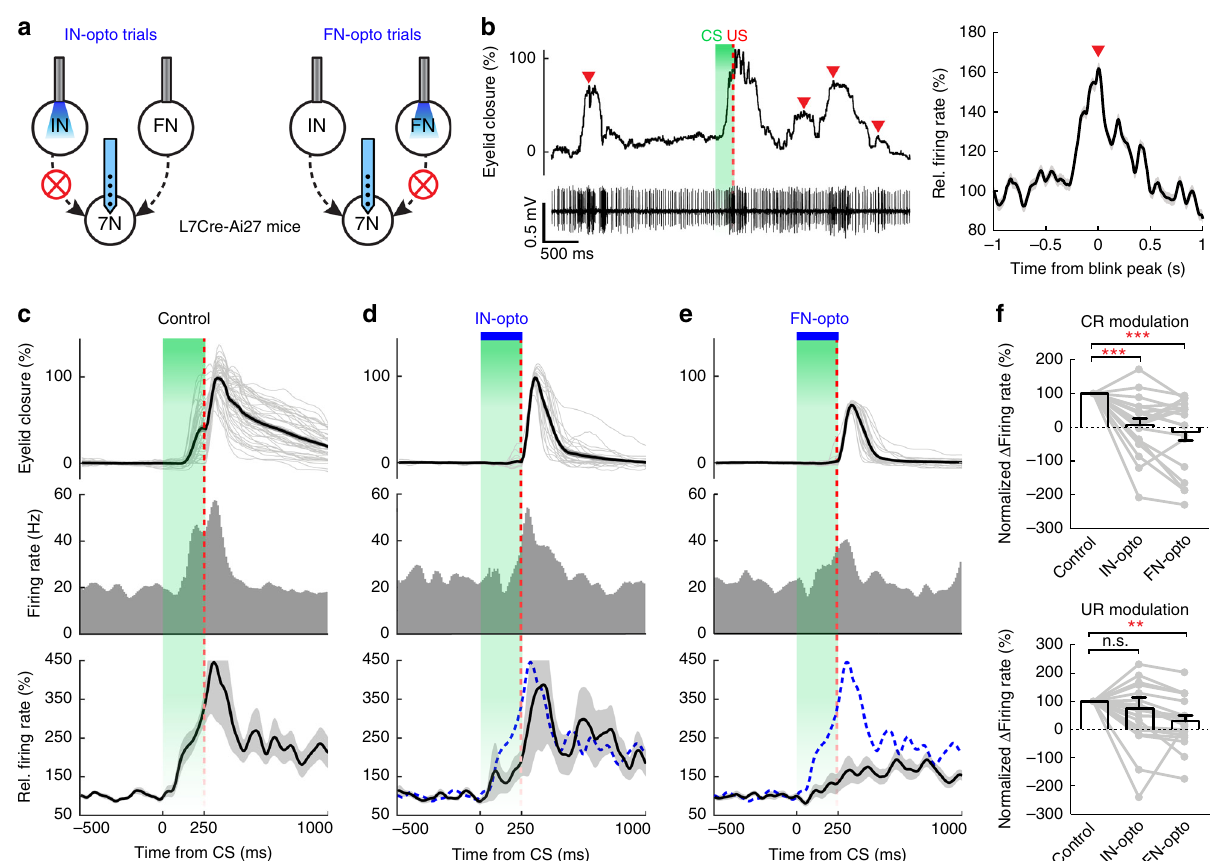
Fig. 7 Integration of FN and IN signals in 7N motor neurons synergistically controls associative behavior. a Experimental design of 7N neuron recording during DEC from L7cre-Ai27 mice with either IN (left) or FN (right) inhibition. Arrow-headed lines indicate outputs from the IN and the FN to 7N motor neurons. b Putative 7N motor neuron activity during DEC and spontaneous eyelid movements. Left: example recording of eyelid movement (upper) and a 7N neuron (lower) showing spike rate increases in response to the DEC triggers (marked with CS and US) as well as spontaneous eyelid movements (red arrowheads). Right: average relative fi ring rate of all putative 7N motor neurons ( n = 19, mean ± s.e.m) during spontaneous blinking (peak-aligned, red arrowhead). c – e Changes in behavior and 7N neuron activity in the control, IN-inhibition and FN-inhibition trials. Firing rate PSTH of an example 7N neuron (middle row) during behavior (upper row, n = 46, 22, 26 trials for c – e ), showing that both IN and FN photoperturbations (blue bars) inhibited CR and neuron activity in response to CS, while only FN-inhibition suppressed UR and neuron activity in response to US. Lower: average spike modulation of all 7N neurons ( n = 19, mean ± s.e.m). Dashed-line trace indicates the average activity during control trials in ( c ). f Summary of changes in relative fi ring rates of 7N motor neurons in response to CS and US in control, IN-opto and FN-opto trials ( n = 19, mean ± s.e.m., paired two-sided t test, ** P < 0.01, *** P < 0.001). CR and UR modulation ( Δ Firing rate) are normalized to the corresponding fi ring rate changes of the control session. See the exact P values for each comparison in the Source Data fi